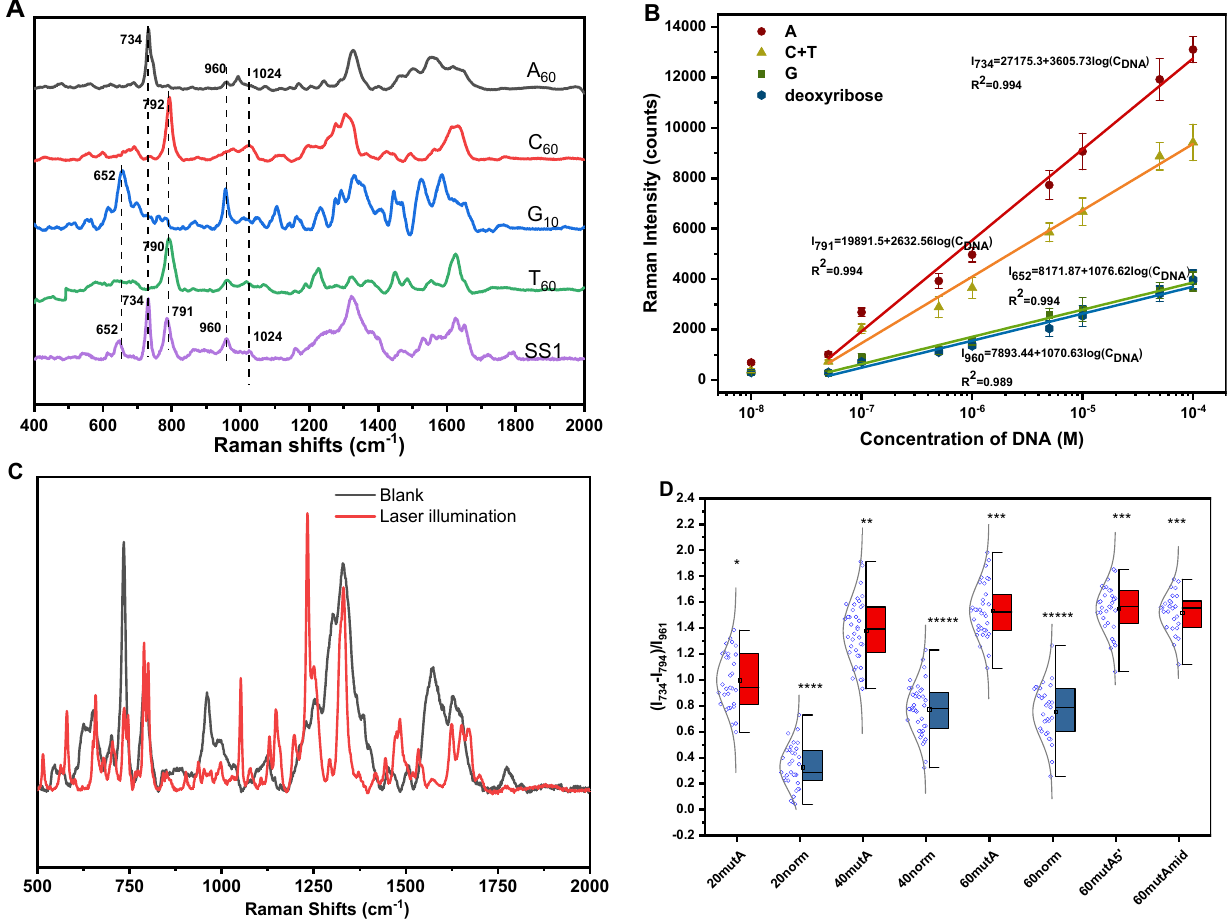
Figure 2. ( A ) Normalized SERS spectrum of homopolymeric DNA sequence and SS1. The characteristic peaks of each base of SS1 have been marked by comparison by the spectrum of homopolymeric DNA. ( B ) Linear relationship between the concentration of 60–nt DNA (SS1) and the Raman intensity of each base. Peaks at 652, 734, 791, 960 cm –1 are assigned to guanine (G), adenine (A), thymine (T), cytosine (C), and deoxyribose (dR), respectively. ( C ) SERS spectra change of the DNA adsorbed on the AgMC surface after irradiation by 633 nm laser. ( D ) Statistical analysis and distribution of the ratio after C mutated to A in different lengths of DNA sequence and position.